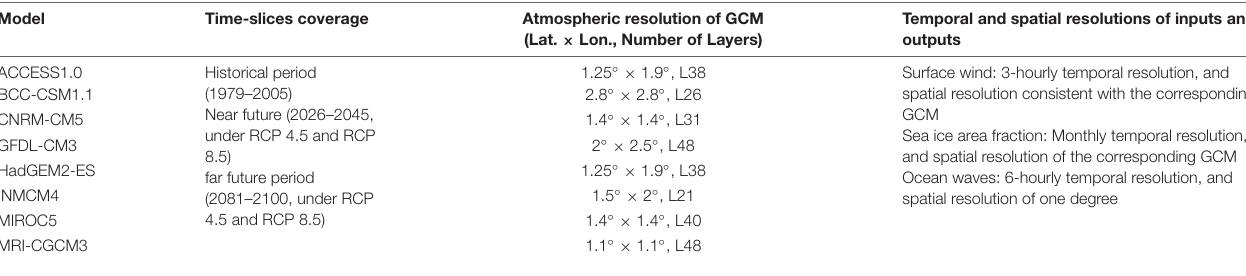
TABLE 1 | Main features of GCM-forced wave simulations conducted by CSIRO.